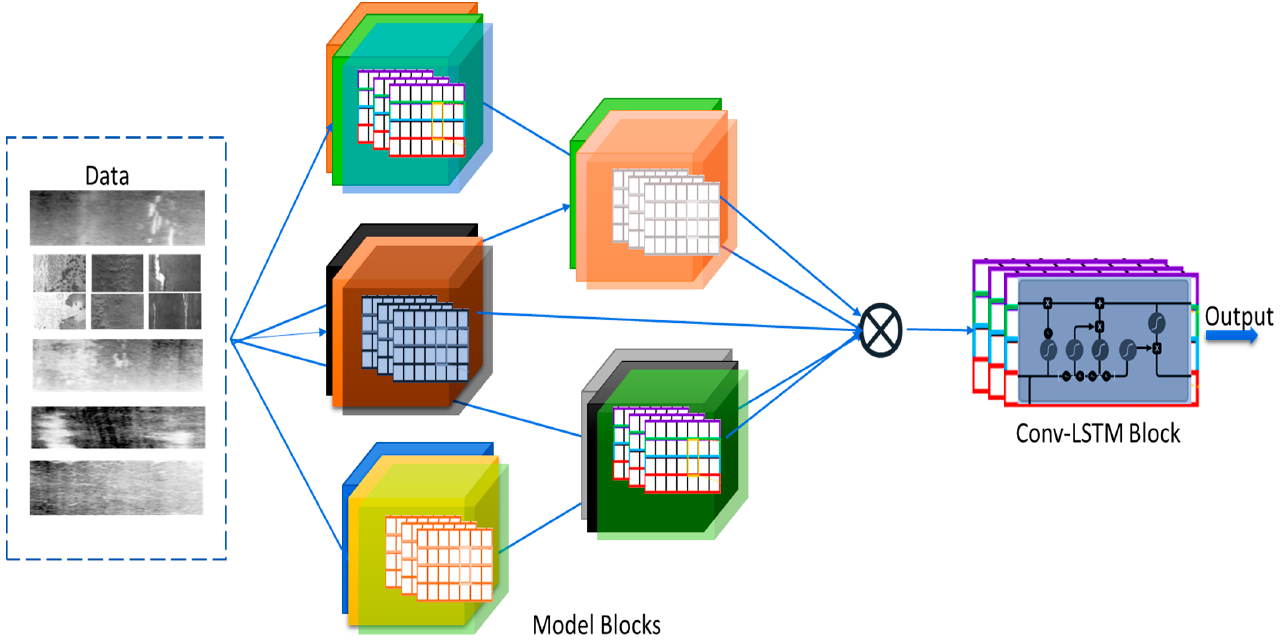
Figure 1. The flow sketch of the proposed Weighted Averaging Sequence-based Meta-learning En- sembler.